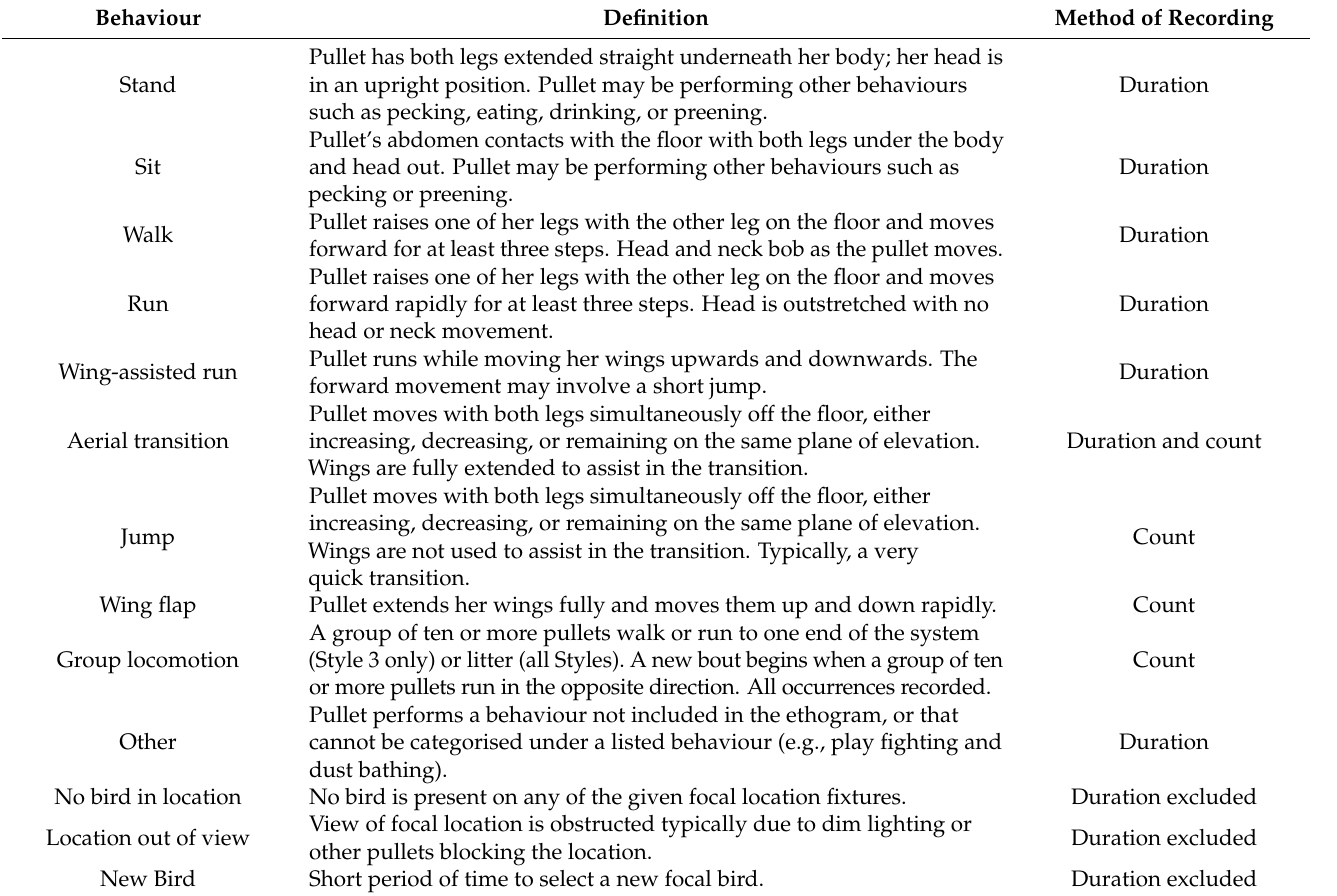
Table 2. Ethogram used for